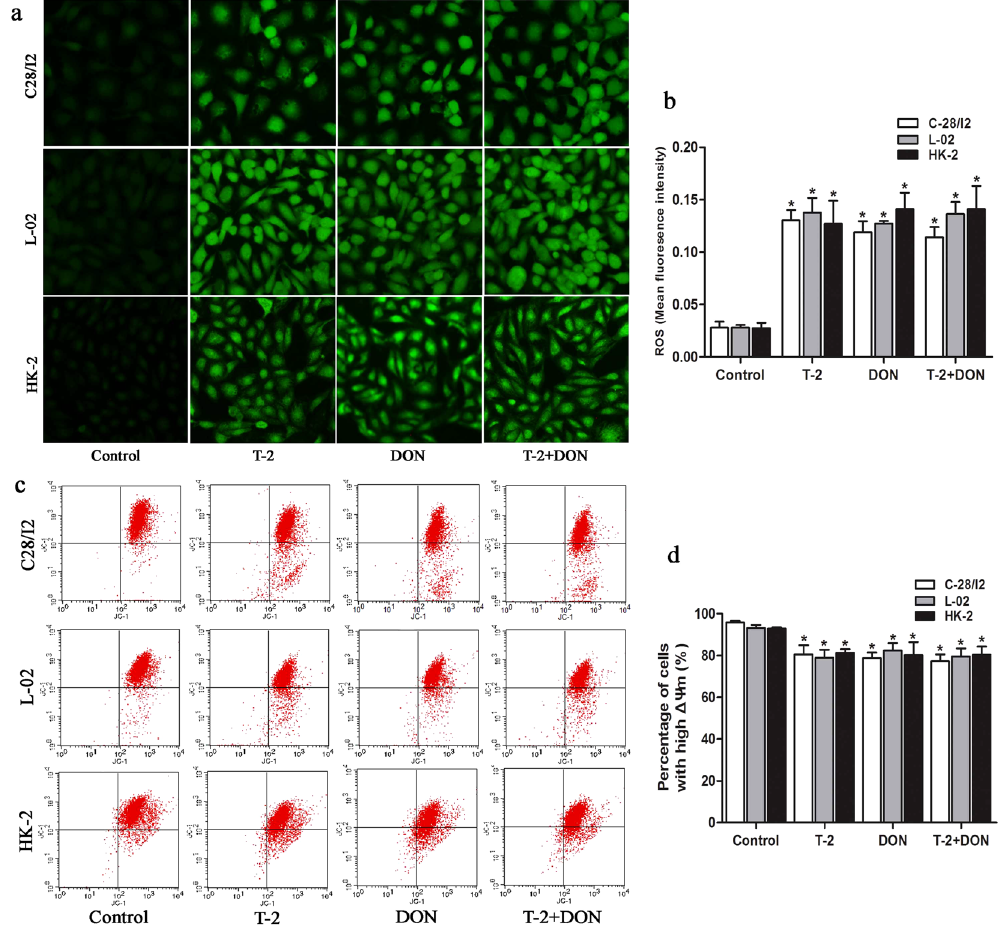
Figure 7. Oxidative stress and mitochondrial membrane potential induced by T-2 toxin and/or DON. C28/I2, L-02 and HK-2 cells were exposed to T-2 toxin (10 ng/ml) or DON (800 ng/ml), alone or in combination, for 24 h. ( a ) ROS was visualized in cell layers by fluorescence microscopy (Magnification: 200 × ) and ( b ) quantified as ROS fluorescence intensity. ( c ) The changes in ΔΨ m were analyzed by flow cytometry and ( d ) quantified as the percentage of cells with high ΔΨ m. Data are represented as the mean ± SD from three independent experiments; * P < 0.05 indicates significant differences versus untreated control values.